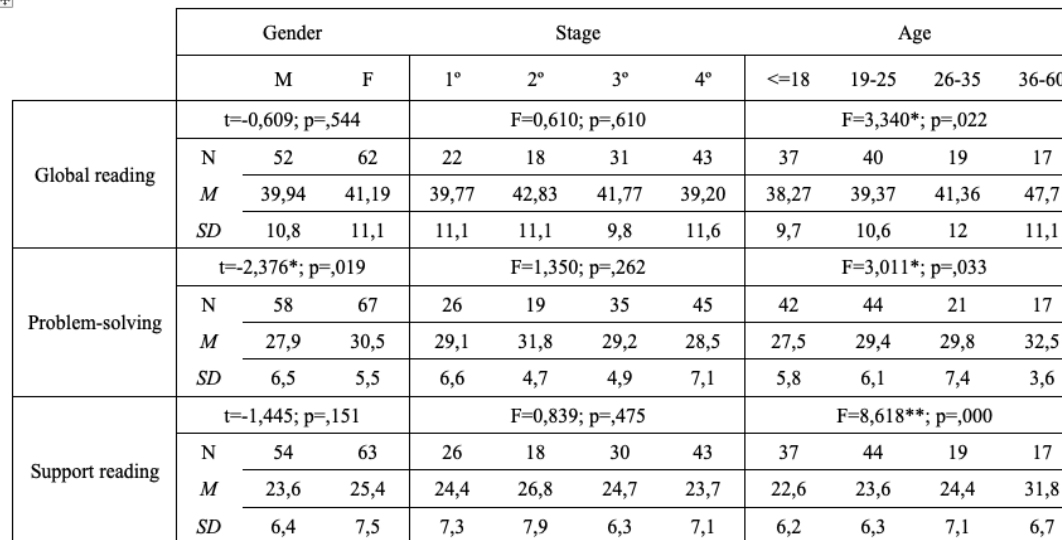
Table 6. Analysis of differences by gender, stage, and age for the MARSI